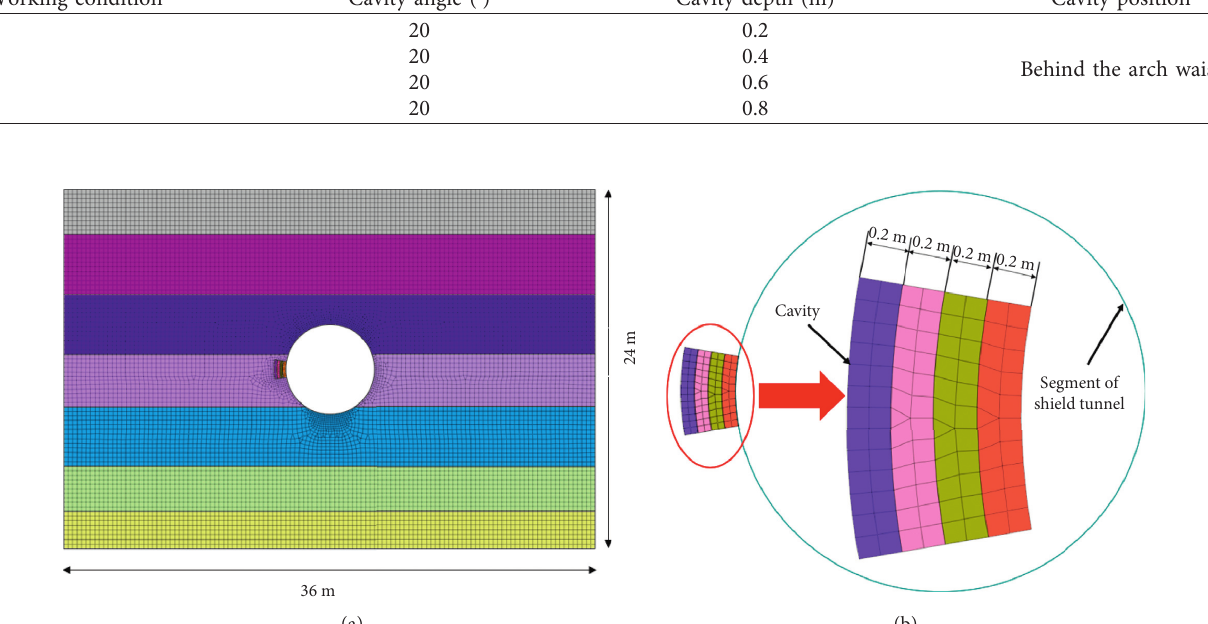
Figure 14: Numerical simulation model of the cavity at different depths. (a) Overall view. (b) Segment structure